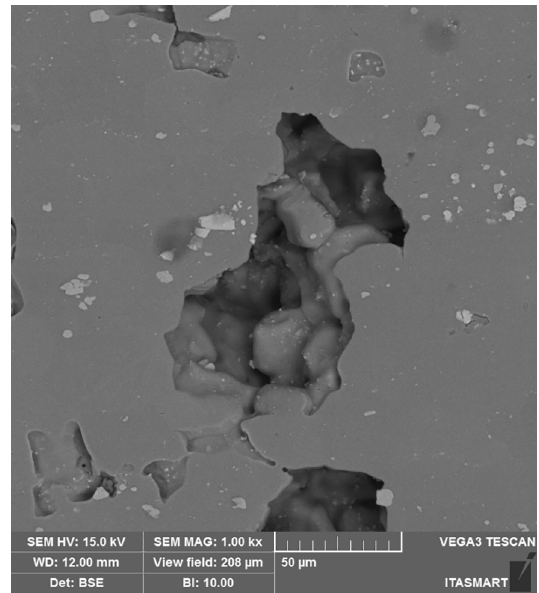
Figure 9. SEM image of the fractured specimen shown in Figure 8 b), the rolling plane is parallel to the